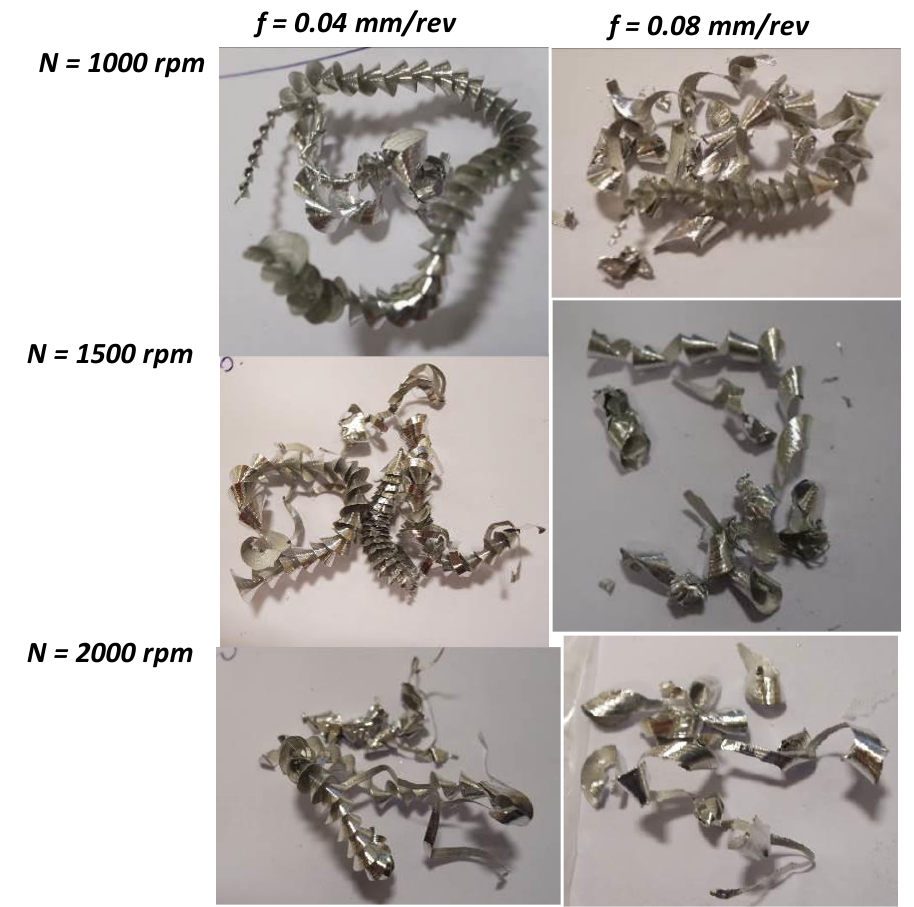
Figure 11. Cutting chips after drilling of 10th hole at different spindle speed and feedrate.